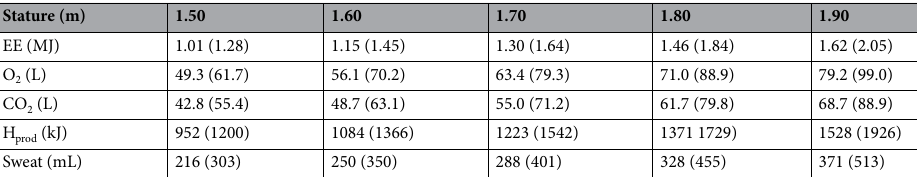
Table 2. Estimated total energy expenditure (EE), oxygen (O 2 ) consumed, and carbon dioxide (CO 2 ), metabolic heat (H prod ) and sweat produced, during a single bout (30-min at 75% VO 2max ) of aerobic countermeasure exercise by theoretical female and male (in brackets) astronaut populations (see 9 ). See main text for definition of